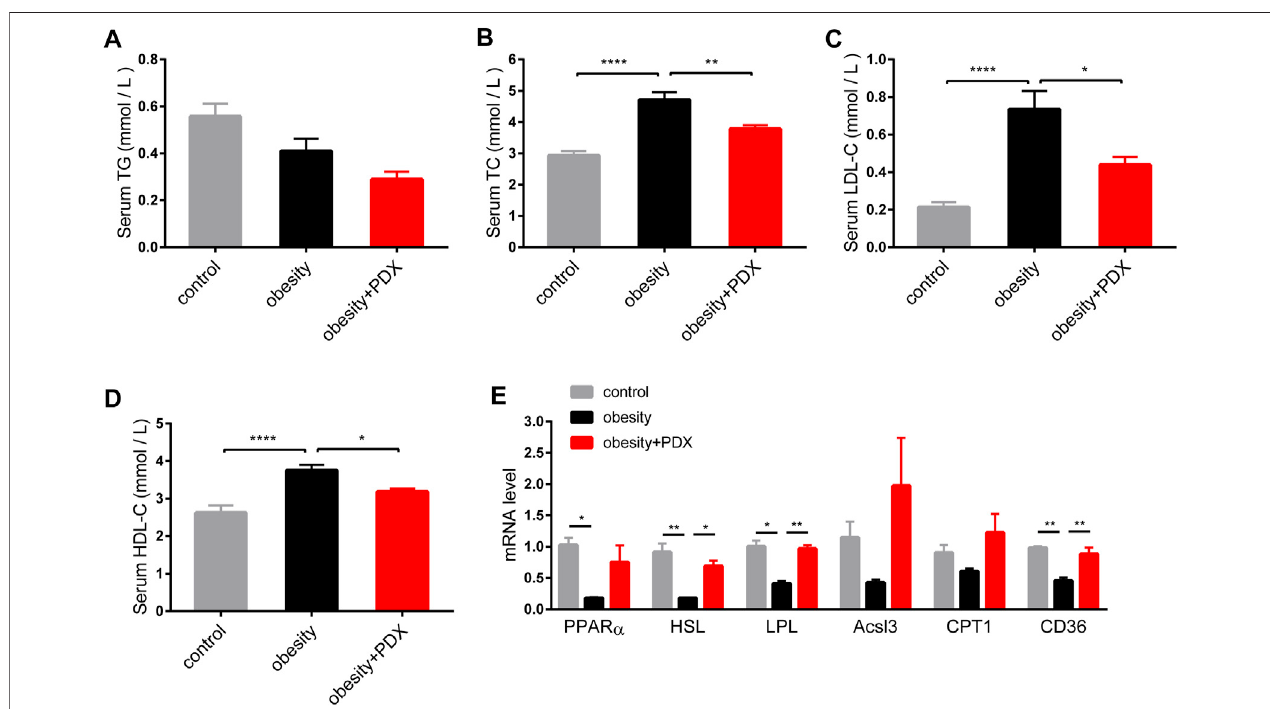
FIGURE6| PDXimproveddyslipidemiainHFD-inducedobesemice(Part2). (A) SerumTG. (B) SerumTC. (C) SerumLDL-C. (D) SerumHDL-C. (E) qPCRanalysis of genes involved in lipid metabolism PPAR α , HSL, LPL, Acsl3, CPT1 and CD36 in epididymal adipose tissue. n (cid:2) 10 (A – D) or n (cid:2) 4 (E) per group. * p < 0.05; ** p < 0.01; *** p < 0.001; **** p <